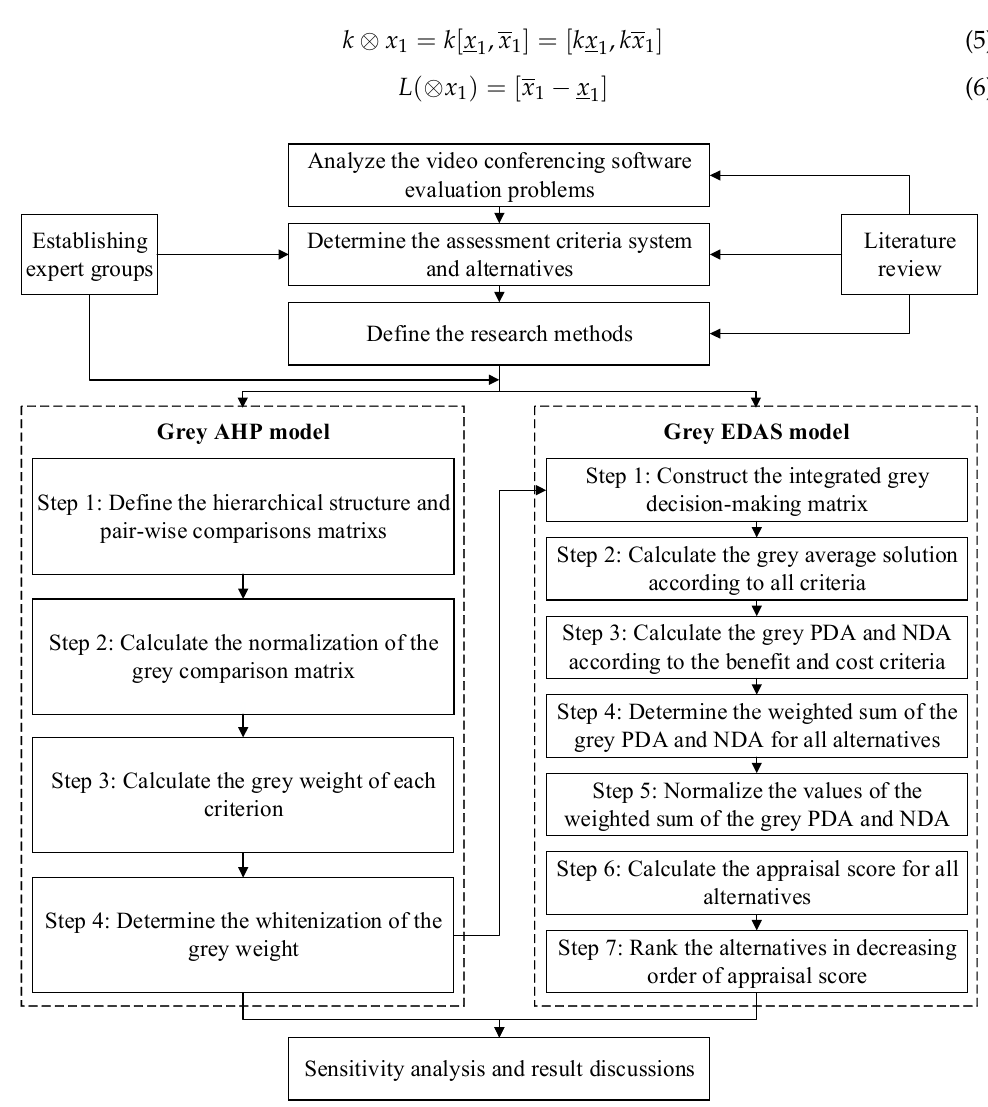
Figure 1. The proposed research framework used in this paper.